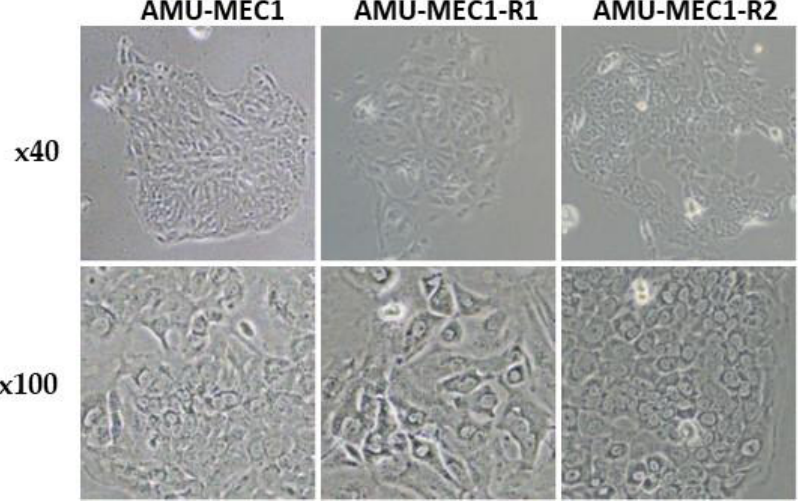
Figure 1. The morphology of the AMU-MEC1, AMU-MEC1-R1, and AMU-MEC1-R2 cell lines. Microscopic images of the MEC cell lines are shown at magnifications of ×40 (upper panels) and ×100 (lower panels), respectively.